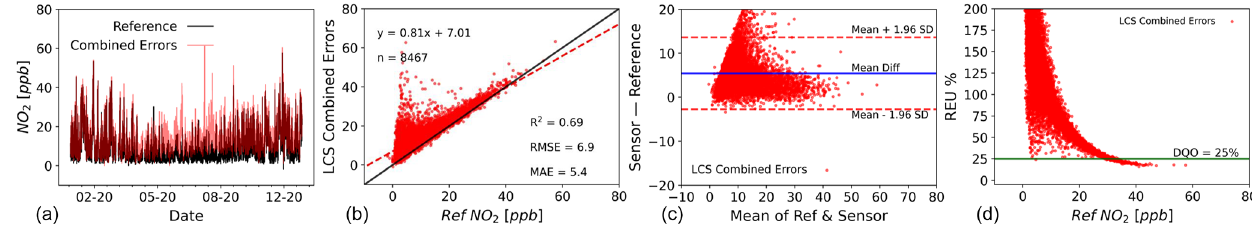
Figure 4. Time series (a) , regression ( b , including R 2 , RMSE and MAE), Bland–Altman (c) and REU ( d , DQO for NO 2 = 25%) plots for a linear combination of temperature, ozone and thermal electrical noise modelled interferences (time res